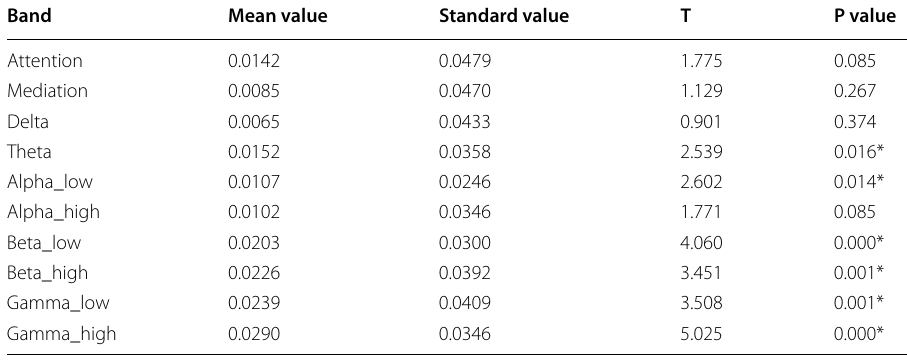
Table 3 Comparison of BS level between problem‑understanding and problem‑solving stages